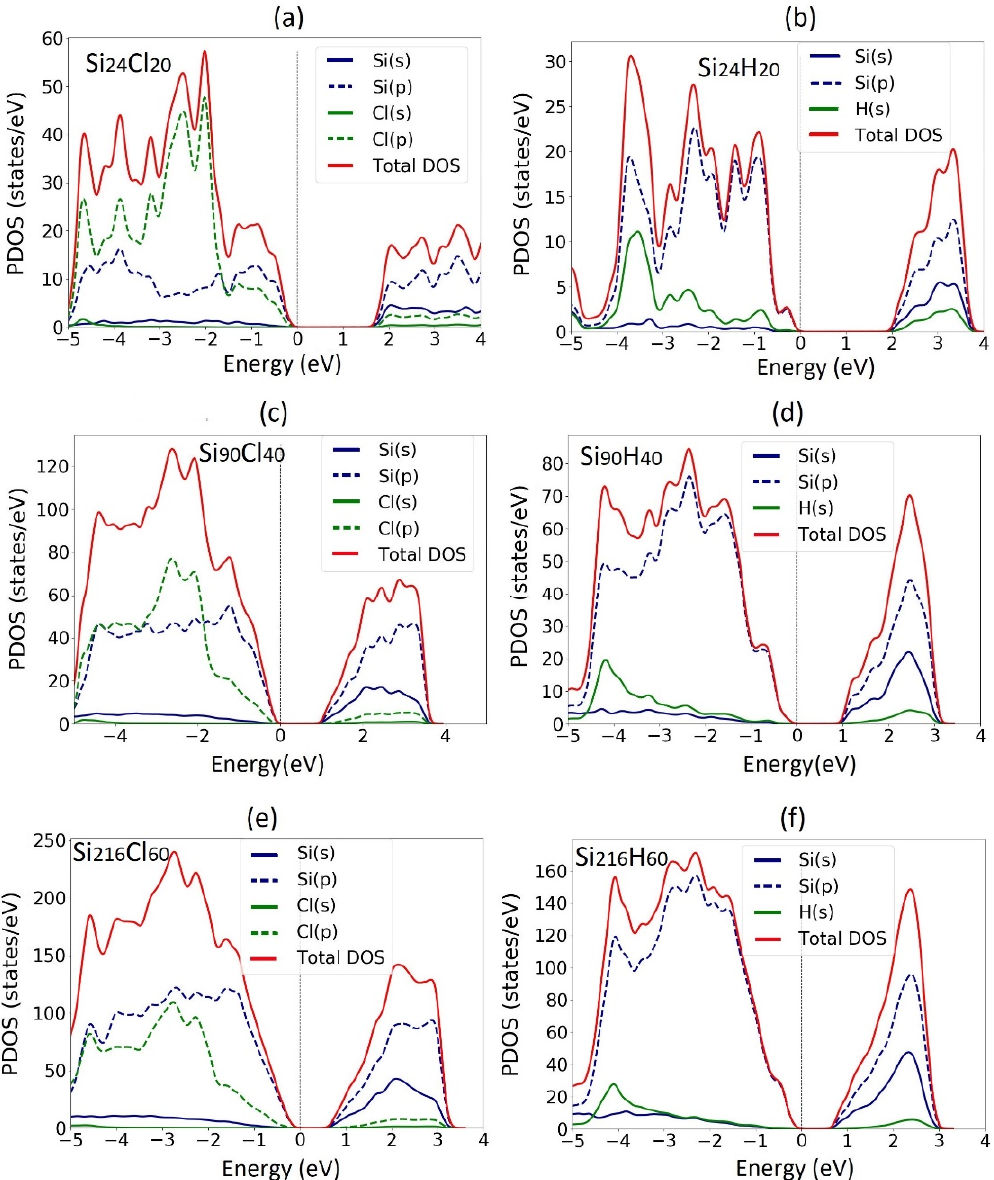
Figure 4. Projected electron density of states (PDOS) of fully Cl- and H- functionalized <112> oriented SiNWs: ( a , b ) small; ( c , d ) medium; ( e , f ) large SiNW.